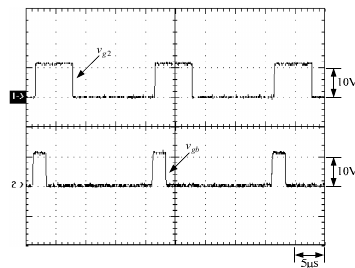
Figure 26. Waveforms pertaining to S 2 and S b at the rated load: (1) v g 2 ; and (2) v gb .